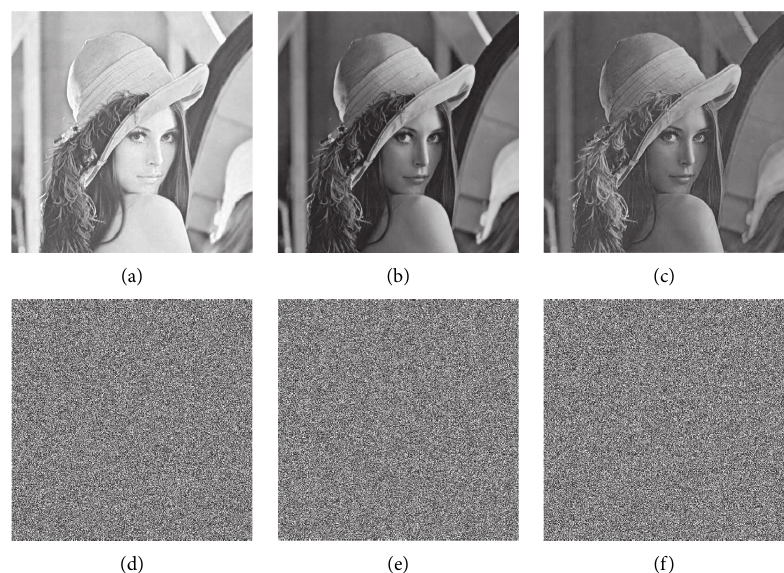
Figure 8: Every component of plaintext and its ciphertext. (a) Component R of plaintext; (b) component G of plaintext; (c) component B of plaintext; (d) component R of ciphertext; (e) component G of ciphertext; (f) component B of ciphertext. Table 2: Comparison of key spaces among different schemes. The number of keys Key space